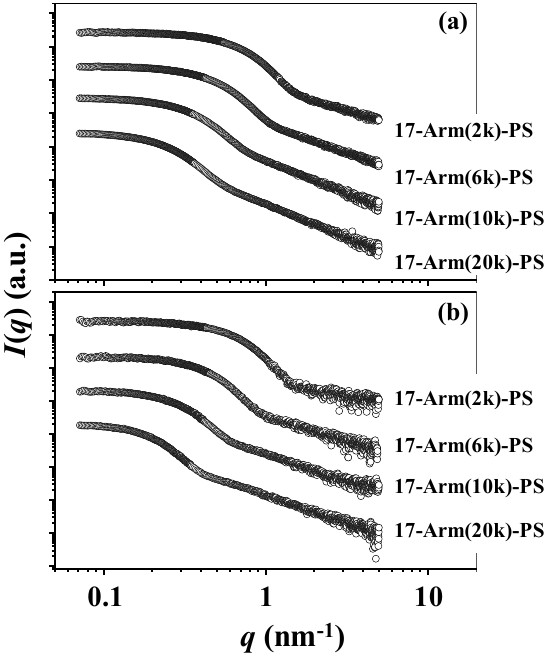
Figure 2. X-ray scattering data of 17-armed star polymers measured using an X-ray beam ( λ = 0.07336 nm): ( a ) measured in Θ condition (cyclohexane (CHX) at 35.0 °C); ( b ) measured in a good solvent condition (tetrahydrofuran (THF) at 25.0 ° C). q = (4 π / λ )sin θ where 2 θ is the scattering angle.